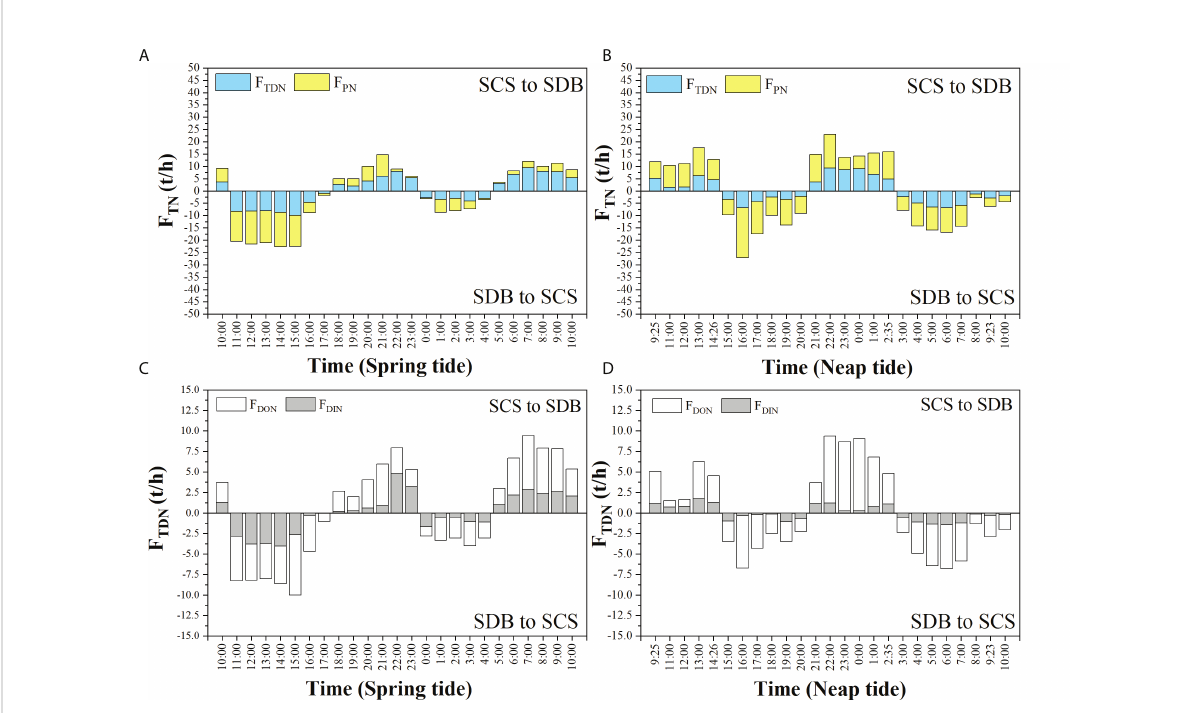
FIGURE 3 During the spring tide, TN (A) and TDN (C) in the exchange fl ux between SDB and SCS. During the neap tide, TN (B) and TDN (D) in the exchange fl ux between SDB and